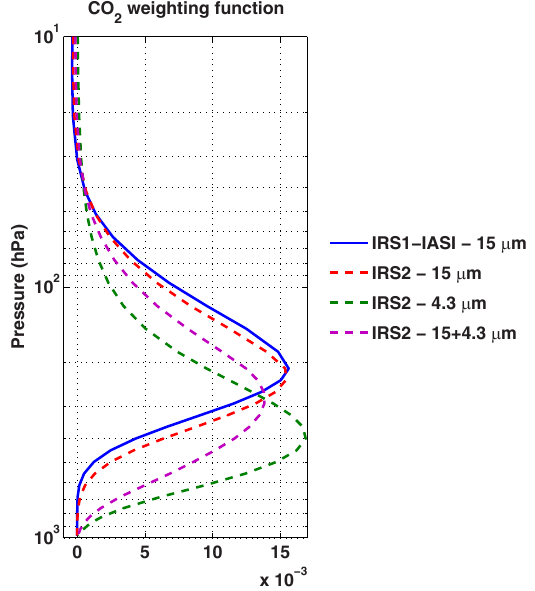
Figure 8. CO 2 weighting function associated with the retrieval for IRS1 scenarios using the channels located in the 15µm CO 2 ab- sorption band only (red) and for the IRS2 scenarios using the chan- nels located either in the 15µm CO 2 absorption band (blue), in the 4.3µm CO 2 absorption band (dashed green), or in both bands (dot- dashed